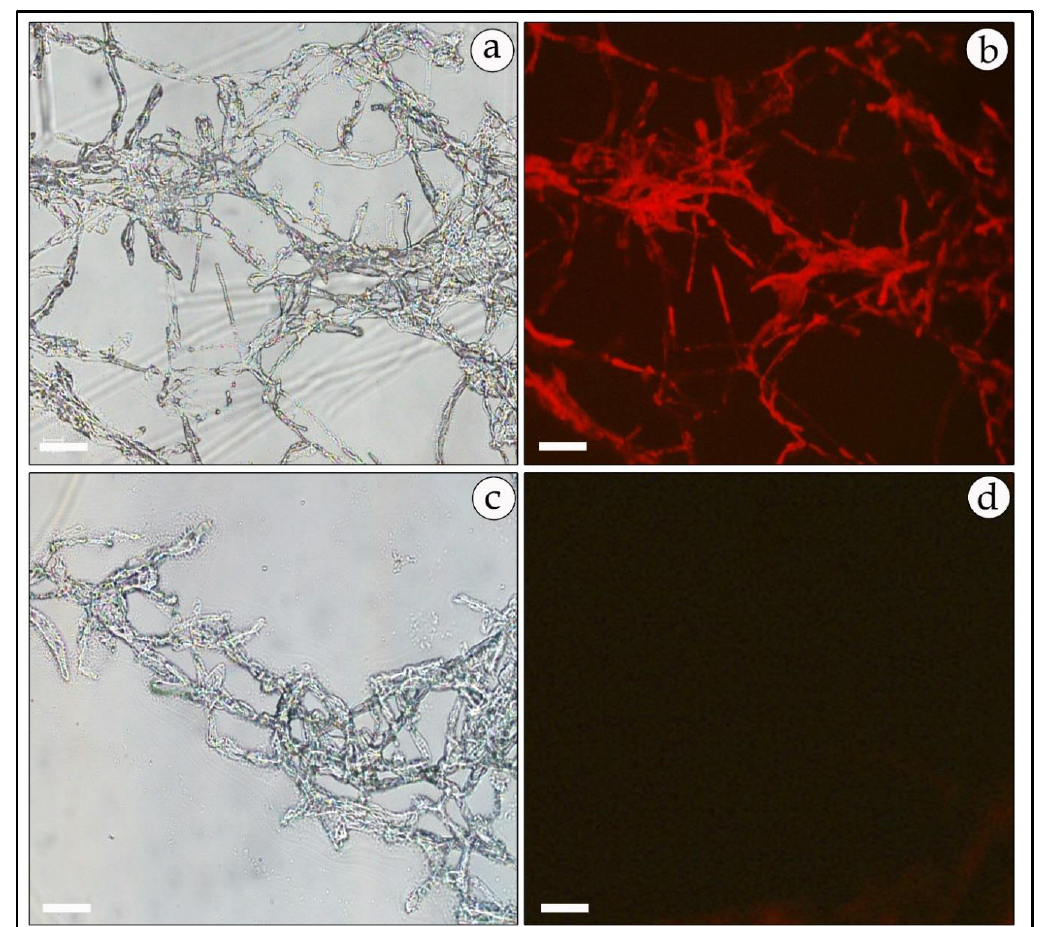
Figure 8. Fluorescent micrograph of RFP-expressing, hygromycin-resistant mycelia of T. boudieri . Transformed mycelia were observed under florescent microscopy. Left panels: bright field optics; right panels t: fluorescence microscopy. Panels ( a , b )—mycelia of RFP-expressing transformants; panels ( c , d )—non-transformed mycelia. 200× magnification. Bar = 20 μm. Genes 2020 , 11 , x FOR PEER REVIEW